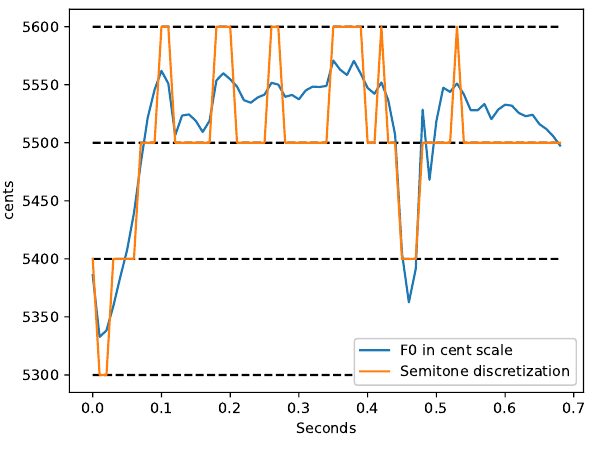
Figure 3. Discretisation of a f 0 curve.